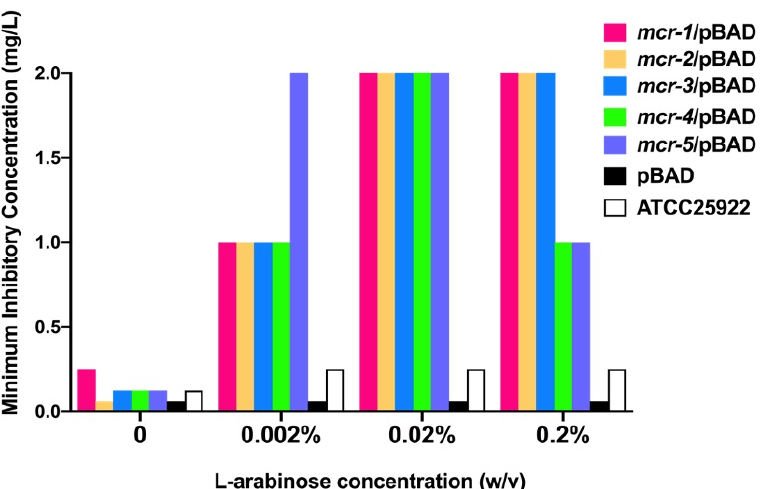
Figure 1. MICs of colistin to constructed strains in the presence of 0–0.2% ( w/v ) L-arabinose in broth.